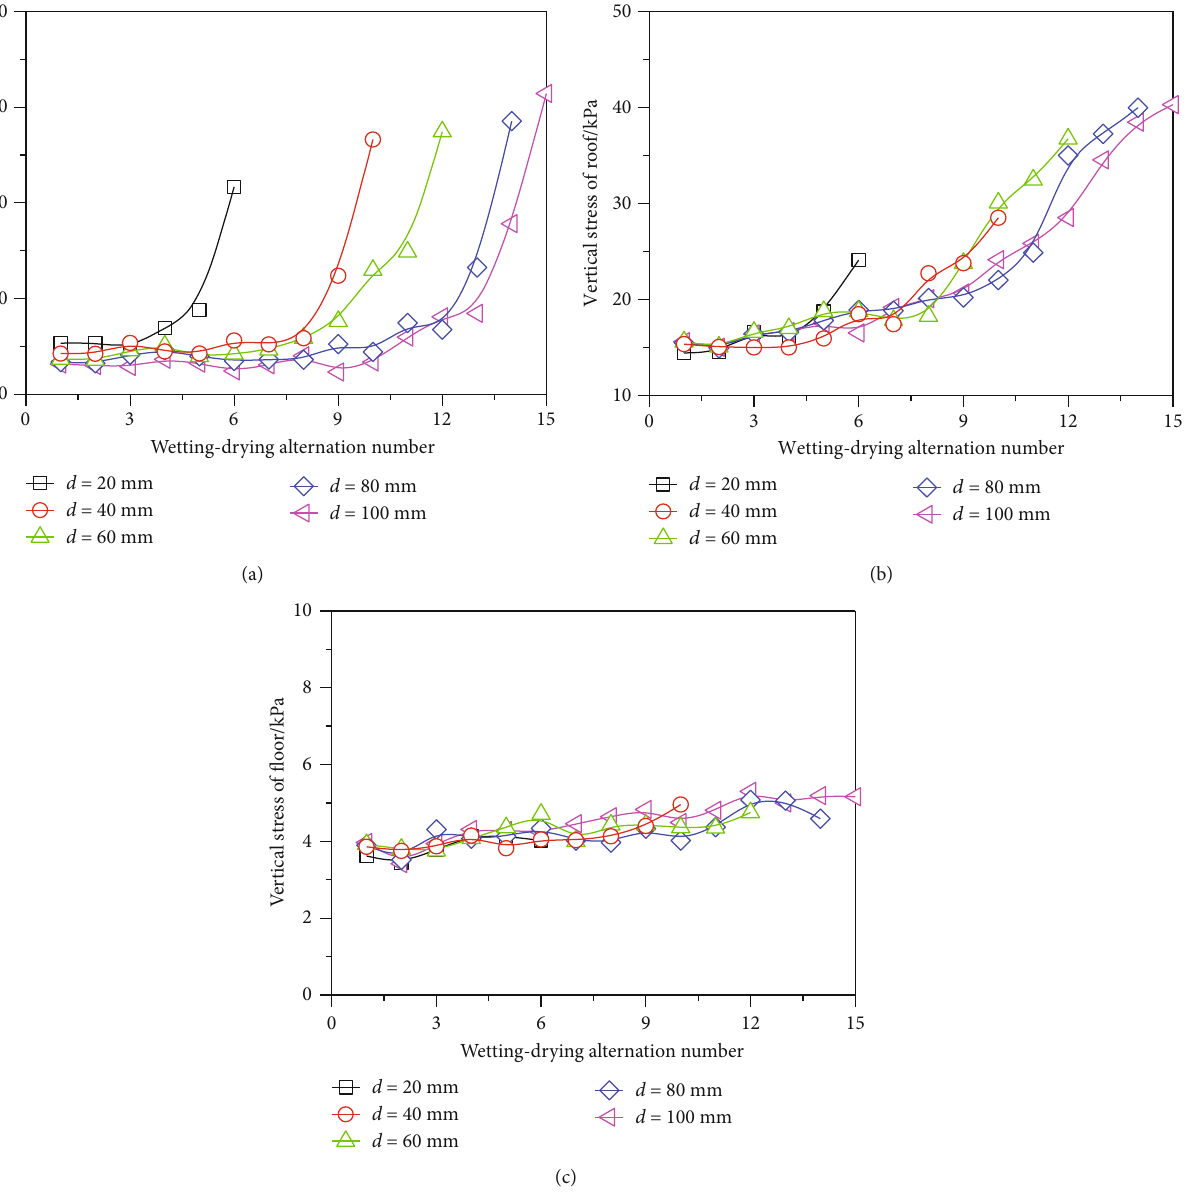
Figure 8: Variations in vertical stresses of surrounding rock with the increase of wetting-drying alternation number: (a) right side wall, (b) roof, and (c) fl oor,